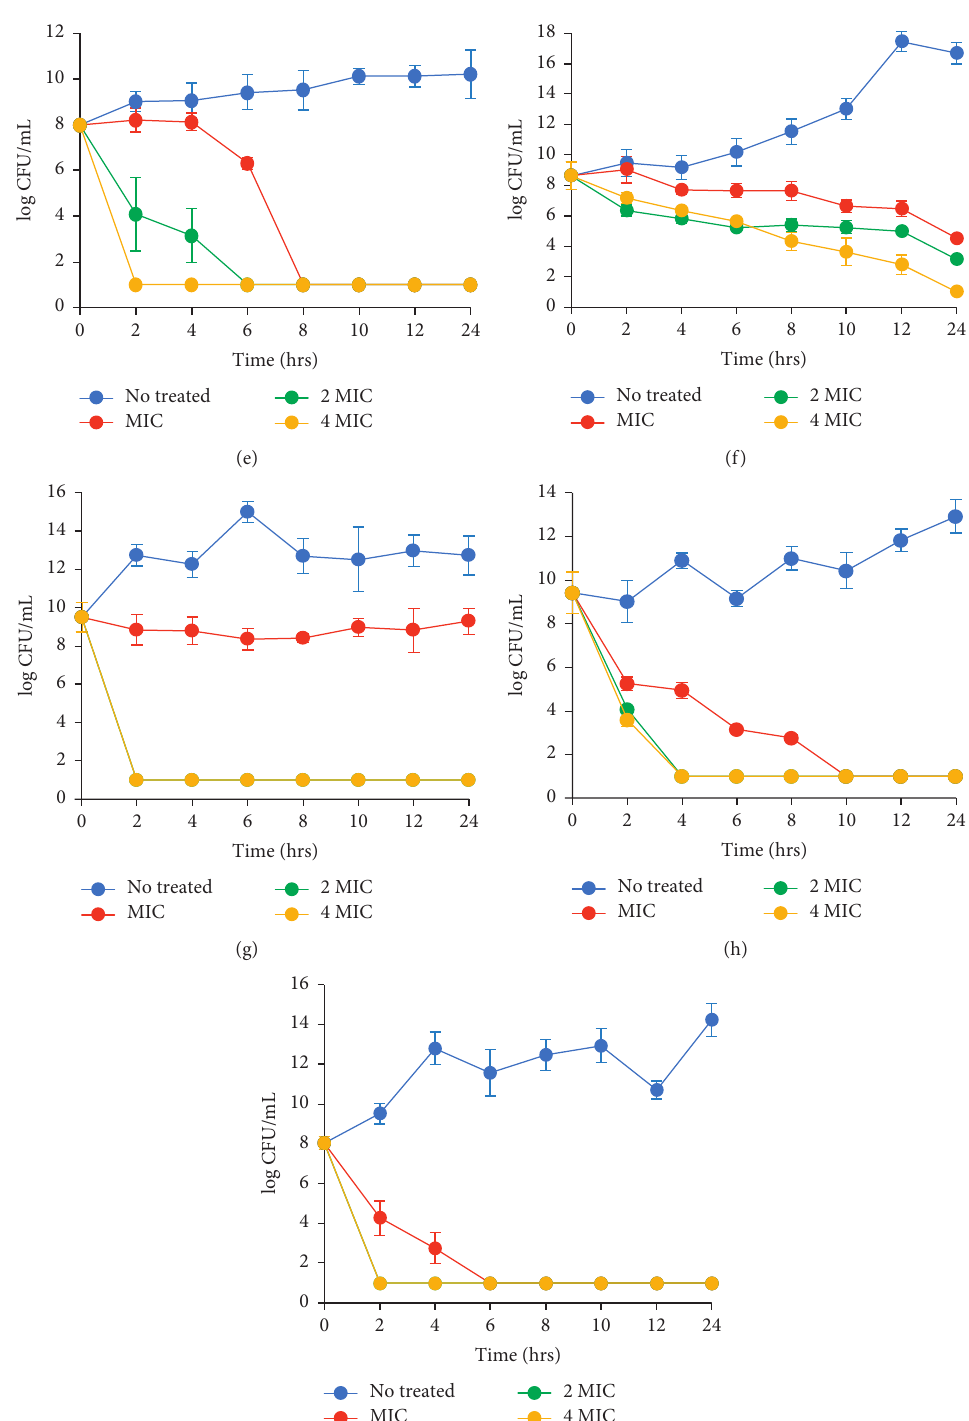
Figure 1: Time-kill plots of C. garettiana extract against S. aureus (a), E. coli (b), P. aeruginosa (c), MRSA (d), S. dysenteriae (e), S. epidermidis (f), Salmonella Typhimurium (g), Salmonella Typhi (h), and K. pneumoniae